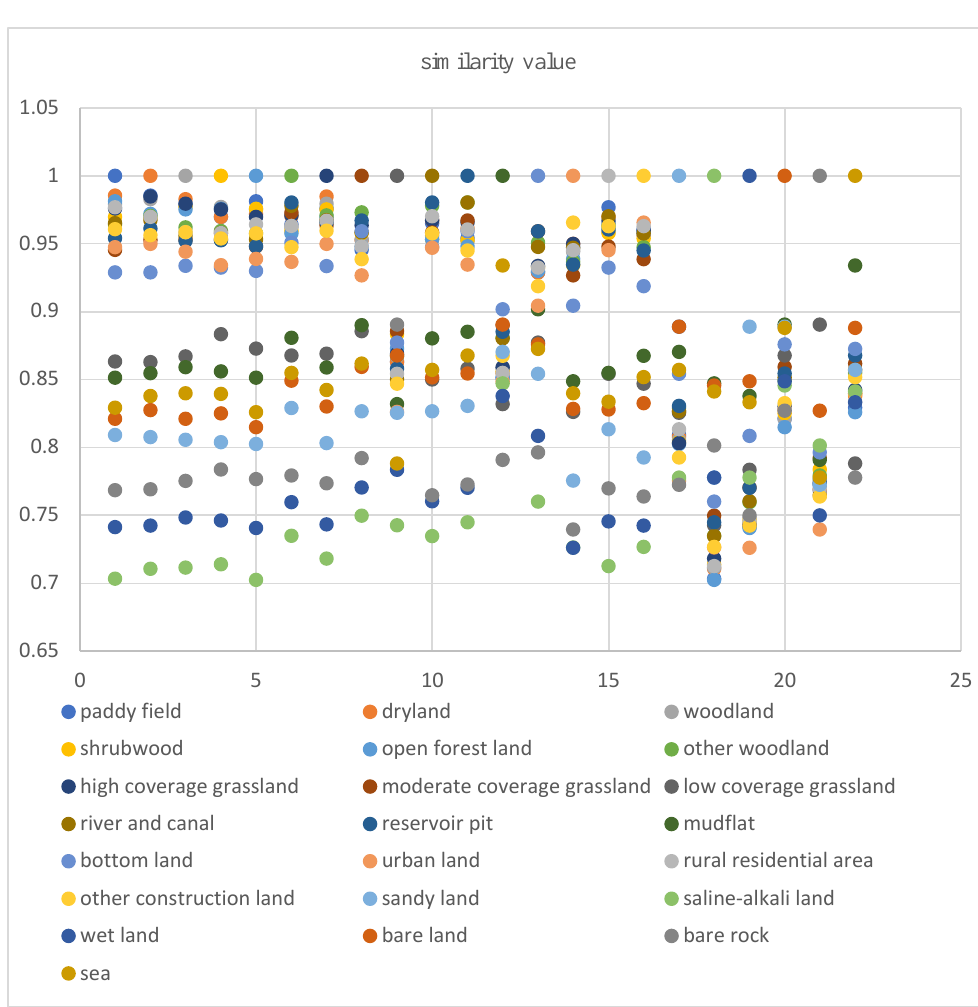
Figure 6. Scatter plot of similarity measures of land use types in Guangxi.